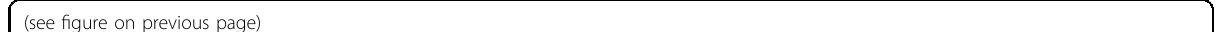
Fig. 5 RSV treatment facilitated the alveolar bone regeneration of P-PDLSC aggregates in a rat periodontal defect model. a Schematic illustrating the experimental design. b Micro-computed tomography (micro-CT)-based schematic demonstrating the establishments of periodontal defects in the rat mandible. The defects were made approximately 1 mm beneath the alveolar bone ridge with an approximately 2 mm × 1 mm range. c Surgical procedures of mandible exposure (left), defect creation (middle), and aggregate transplantation (right) Bar: 1 mm. d Photographs of periodontal defects after PDLSC aggregate-based regeneration. CBB was used as the scaffold. Bars: 1 mm. e – g Representative micro-CT fi gures